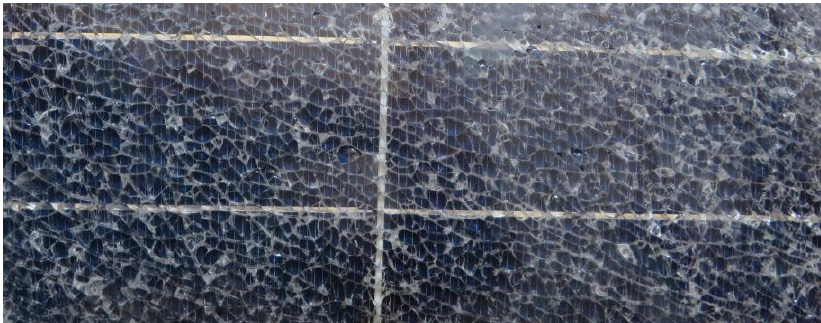
Figure 1. The received EOL solar panels used in the current